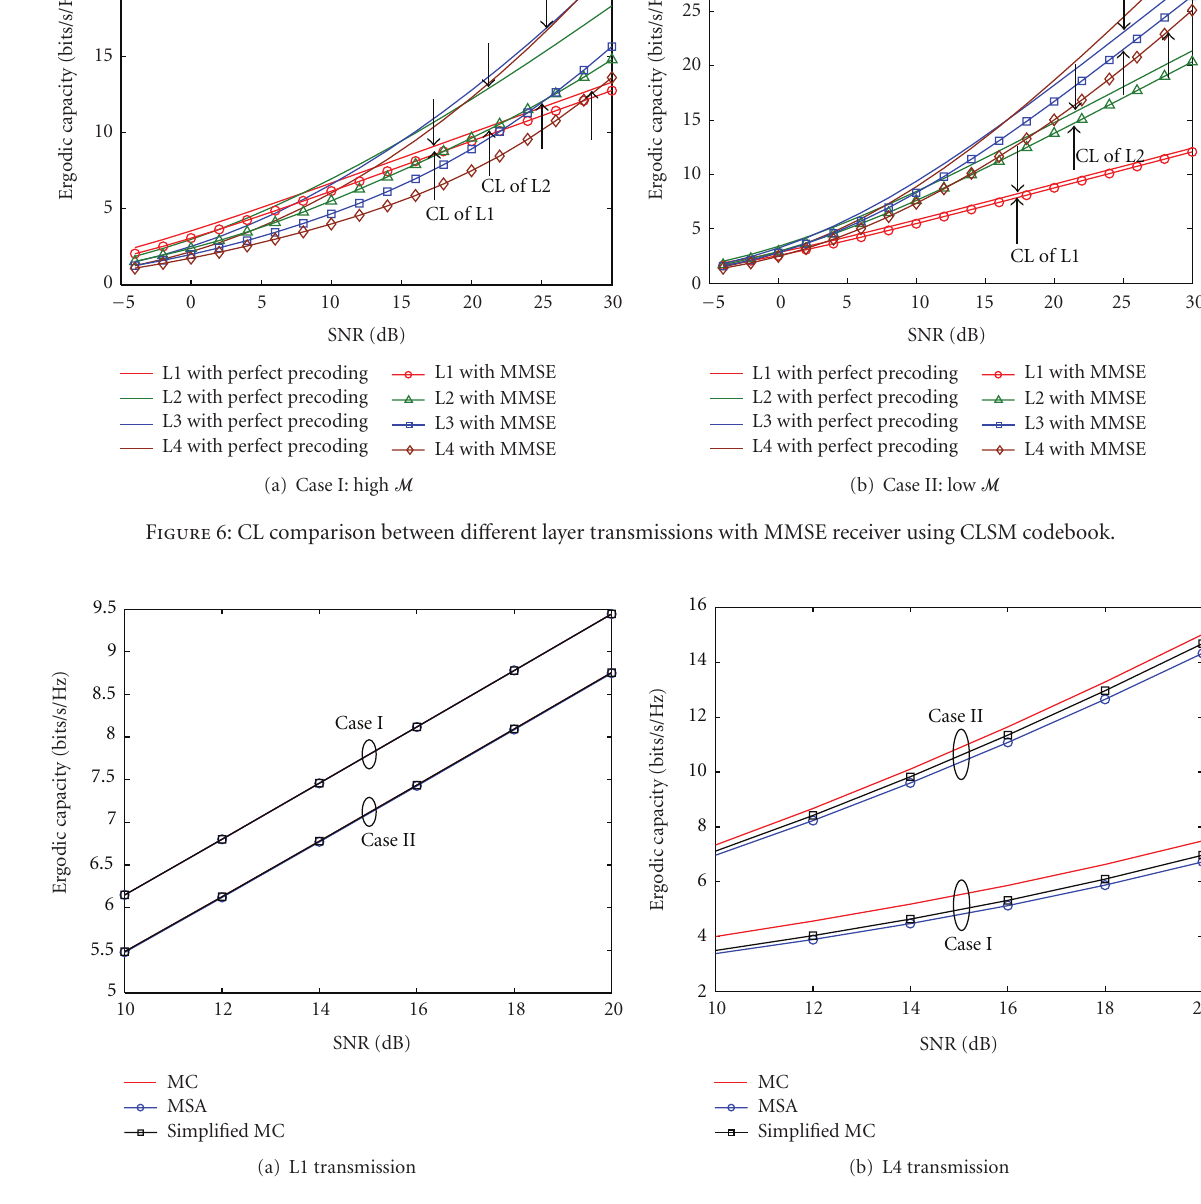
Figure 7: Performance comparison between di ff erent codebook selection criterions for L1 and L4 transmissions with MMSE